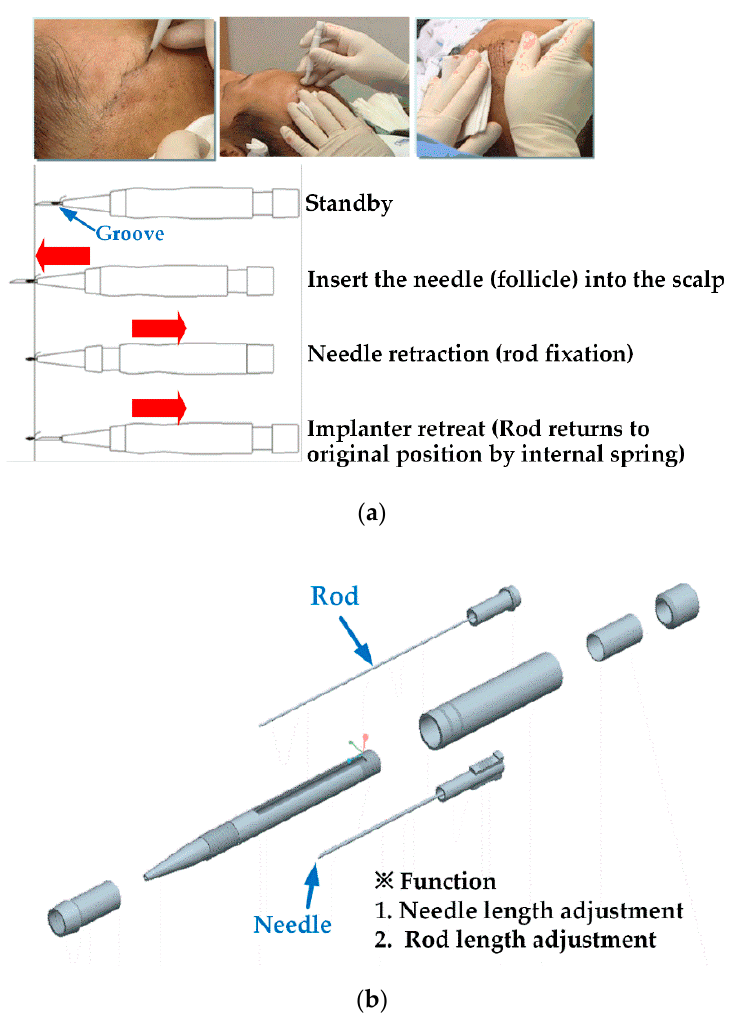
Figure 5. ( a ) Operation sequence and ( b ) configuration of the manual implanter.